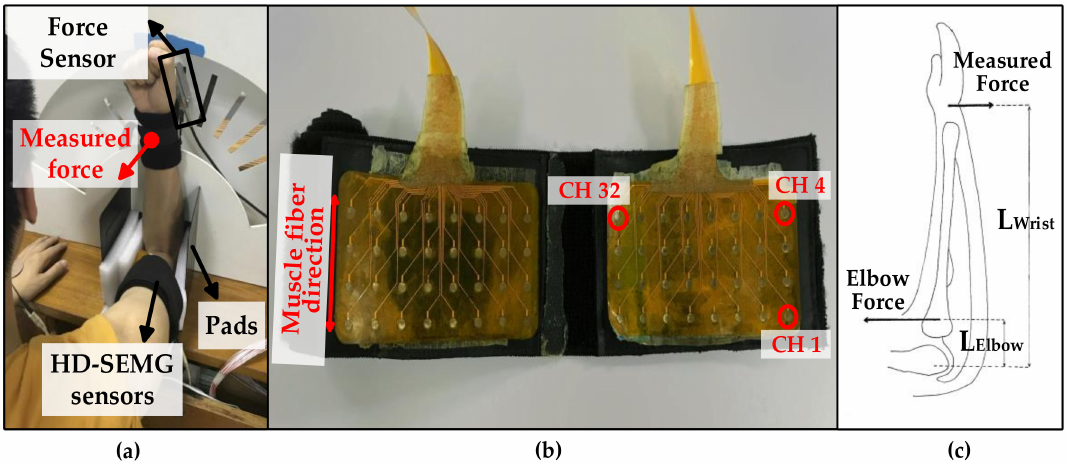
Figure 2. Experimental instrumentation and protocol: ( a ) Illustration of the homemade apparatus and the experimental posture shown by a subject; ( b ) Two high-density electrode grids. ( c ) Free body diagram of the right